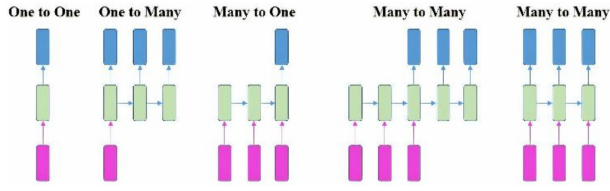
Figure 10. Different series model for RNN.